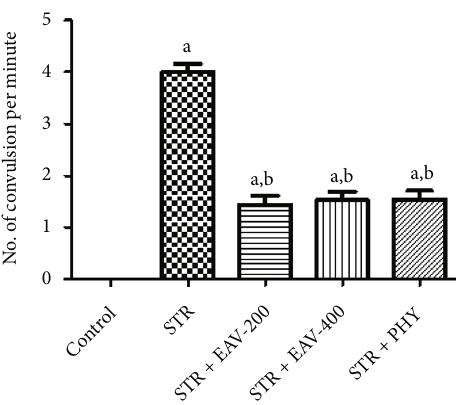
Figure 4: Graph showing the impact of EAV-200, EAV-400, and PHY on convulsion scores. All values are mean ± SEM ( n = 6 ). a P < 0 : 001 , b P < 0 : 001 compared to control and STR, respectively (one-way ANOVA followed by Student – Newman – Keuls post hoc test), c P < 0.001 compared to STR +